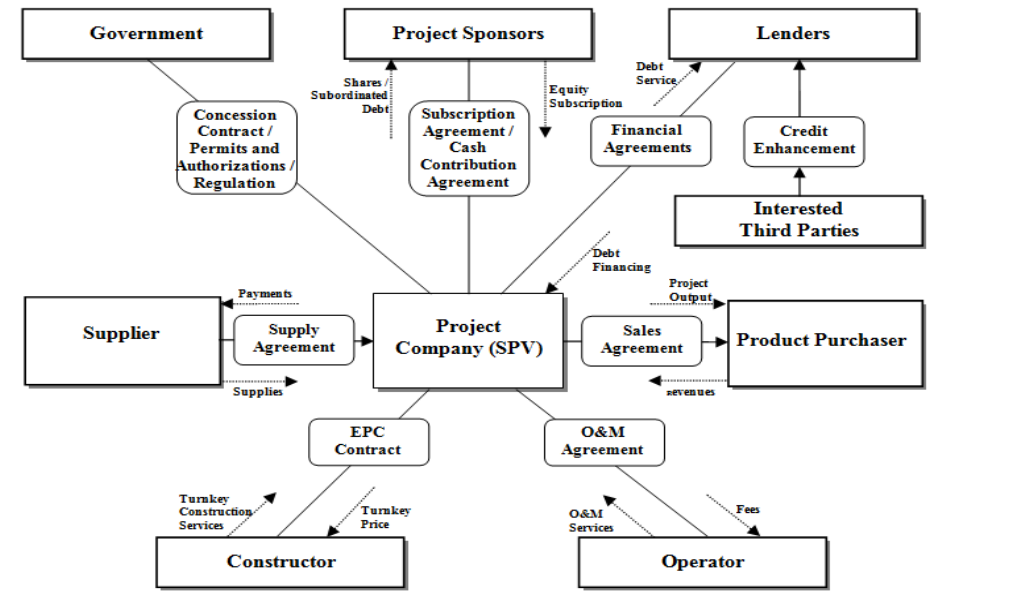
Fig. 1. Typical structure of a project finance